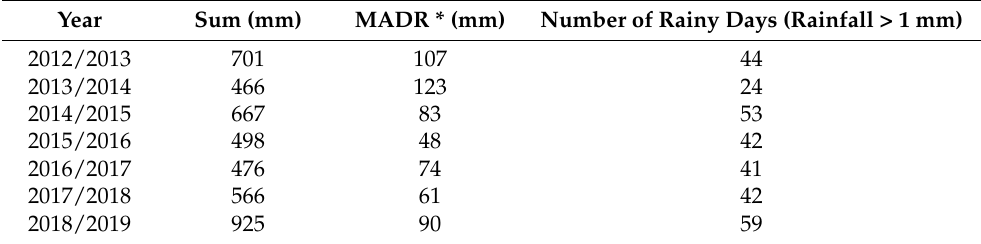
Table 2. Nablus daily rainfall for the period